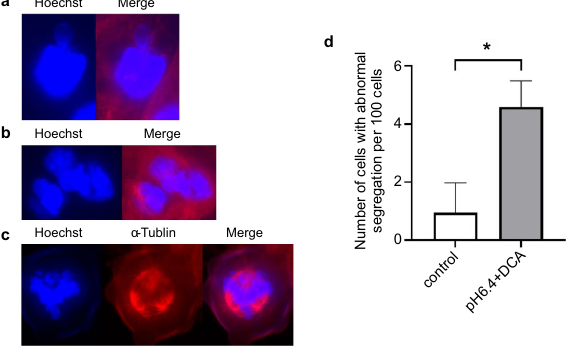
Figure 5. Mitotic abnormalities and number of cells with abnormal segregation in CP-A cell line under induction of DNA hypomethylation of α-Sat. The images represent findings suggestive of mitotic abnormalities such as micronuclei ( a ), and multiple nuclei ( b ), and abnormal segregation ( c ). The number of cells with mitotic abnormalities increased considerably on treatment with acid and bile acid (pH 6.4 + DCA) compared to those without treatment ( d ). The incidence of mitotic abnormalities was evaluated in 100 cells per field and average of 6 fields which was substantially greater in cells with lower pH and DCA. *p <